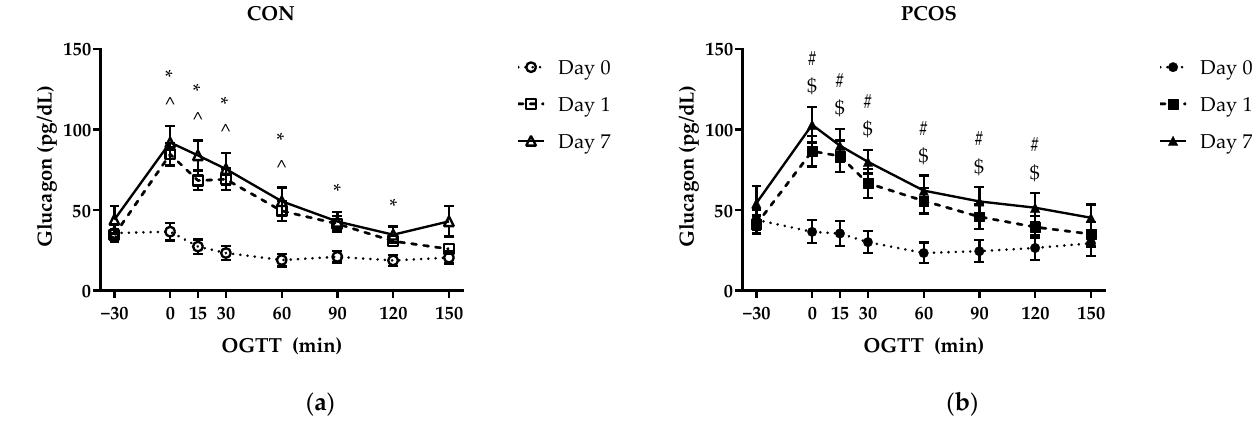
Figure 8. Mean (±SE) glucagon concentrations in ( a ) CON and ( b ) PCOS across timepoints. * = significance between Day 0 and Day 1 for CON; ^ = significance between Day 0 and Day 7 for CON; # = significance between Day 0 and Day 1 for PCOS; $ = significance between Day 0 and Day 7 for PCOS. CON = non-PCOS women; OGTT = oral glycemic tolerance test; PCOS = women with polycystic ovarian syndrome.